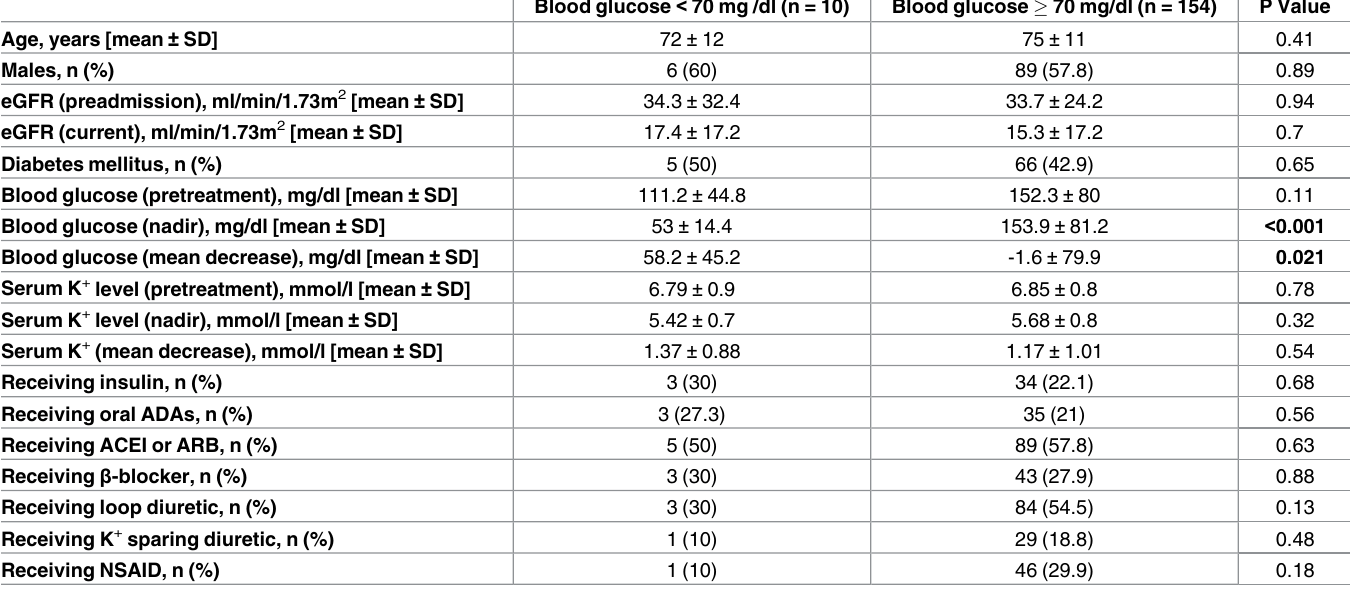
Table 1. Comparison of patient characteristics between those with or without hypoglycemia following the administration of the standardized protocol. Blood glucose < 70 mg /dl (n = 10) Blood glucose (cid:21) 70 mg/dl (n =